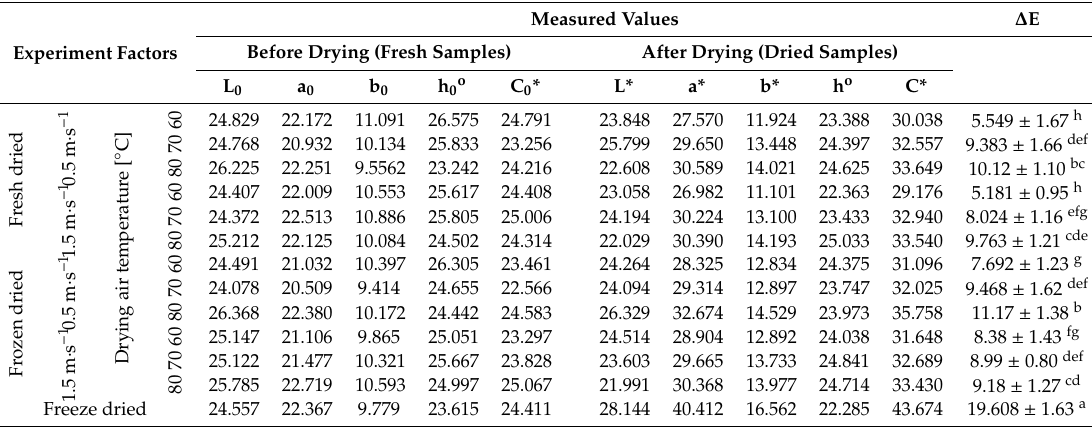
Table 2. Results of CIE Lab parameters before and after all drying treatments: L* (whiteness / brightness), a* (redness / greenness), b* (yellowness / blueness), and ∆ E (color change). Measured Values ∆ E Before Drying (Fresh Experiment Factors